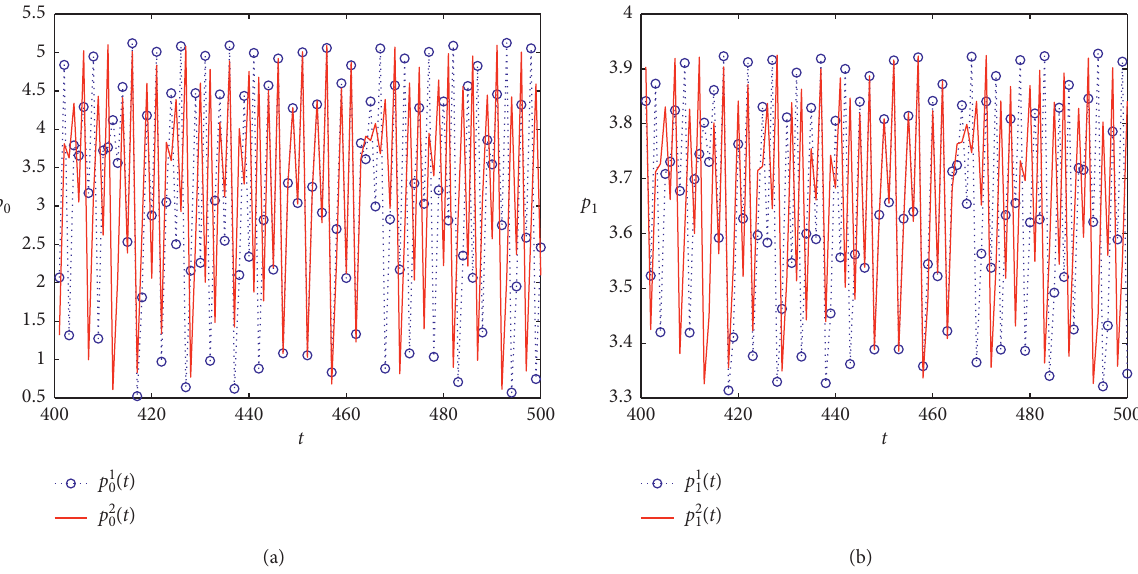
Figure 11: Sensitive dependence on initial conditions for system (33) in the time period [400, 500] when ρ � 0 . 27.